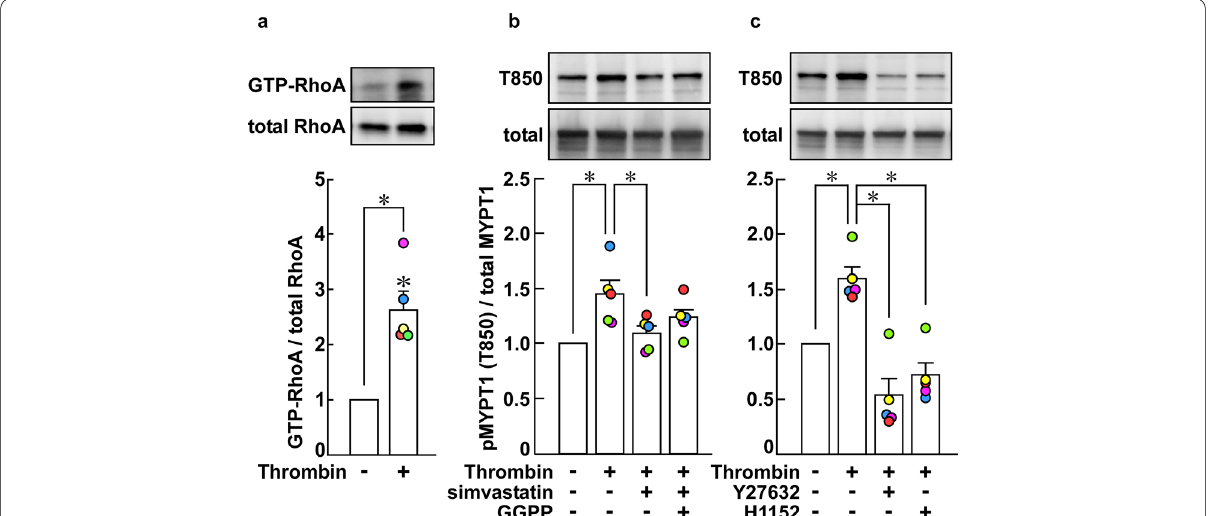
Fig. 4 Activation of RhoA and Rho-associated coiled-coil containing protein kinase (ROCK) by thrombin in porcine aortic endothelial cells (PAECs). a The levels of GTP-bound form of RhoA before and 3 min after stimulation with 1 unit/mL thrombin were summarized ( n 5). b , c Shown are the = representative immunoblots and the summaries of the level of phosphorylation of MYPT1 at the ROCK site corresponding to T850 in human MYPT1 before and 3 min after stimulation with 1 unit/mL thrombin in the presence and absence of 10 µM simvastatin and 3 µM GGPP ( b ; n 5), and 10 µM = Y27632 and 1 µM H1152 ( c ; n 5). PAECs were pretreated with simvastatin for 16 h in the presence or absence of GGPP, and with Y27632 or H1152 = for 30 min, and then stimulated with thrombin in their presence, when pretreated ( n 5). The basal level of MYPT1 phosphorylation was assigned = a value of 1. The data are expressed as the mean SEM. * P < 0.05 vs. thrombin, according to an ANOVA followed by Dunnett’s post hoc test. All ± original images of the immunoblot analyses are shown in Additional file 1: Figure